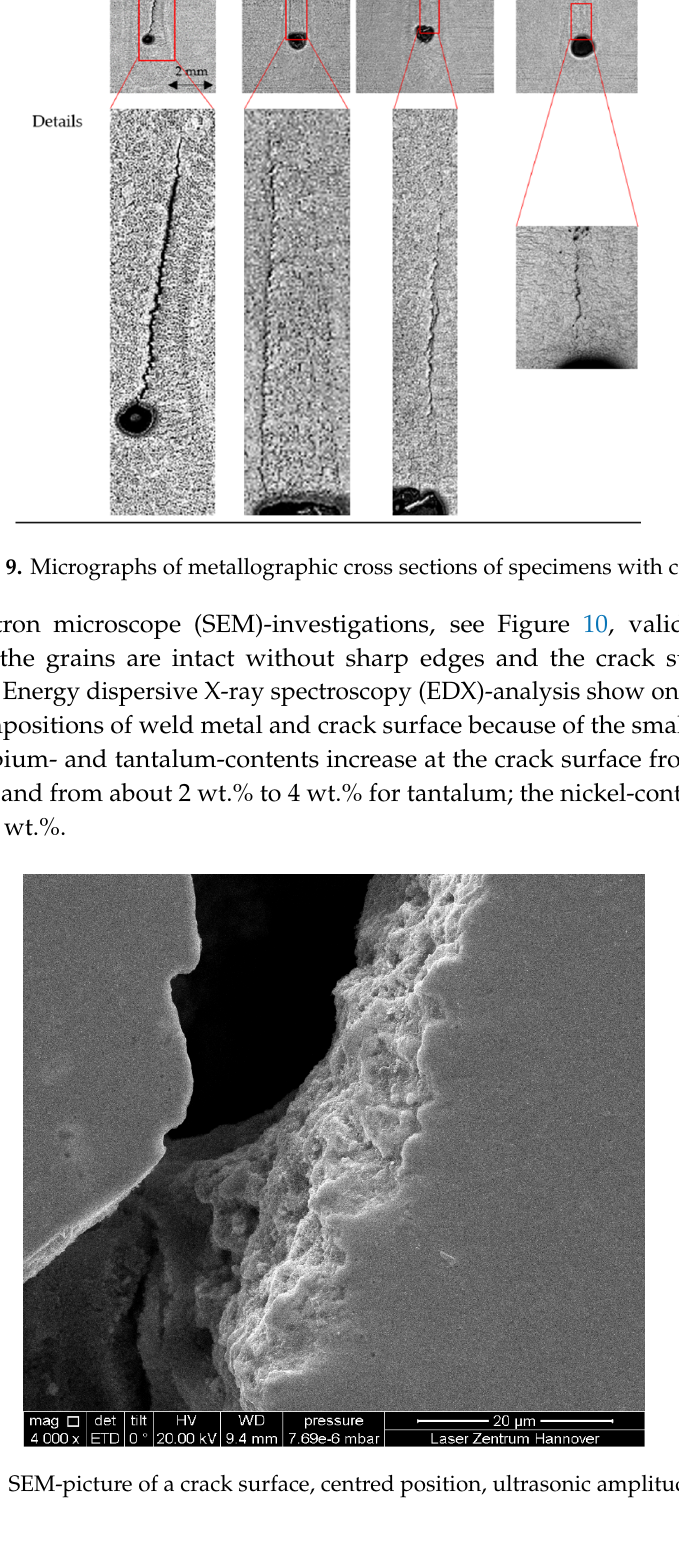
Figure 10. SEM-picture of a crack surface, centred position, ultrasonic amplitude: 4 µm.